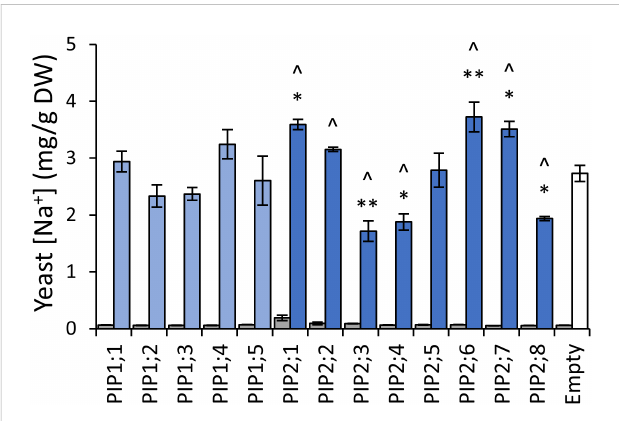
FIGURE 8 Na + permeability assay. Yeast cellular sodium content before (grey) and after (blue) exposure to 70mM NaCl for 40 mins. Error bars are SEM. Asterisks indicate statistical difference from empty vector control, ANOVA with Fishers LSD test (* P < 0.05; ** P < 0.01). Chevrons (^) indicate statistical difference from empty vector control, Student ’ s t test P < 0.05. N = 3 for AtPIPs and N = 2 for empty vector. Two statistical tests were used to provide an added level of statistical resolution for detecting